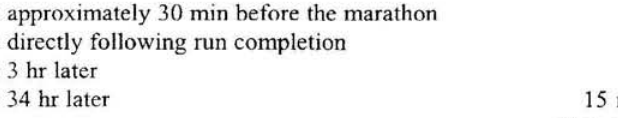
Table 2: Running time, weight loss, fluid intake as well as maximal oxygen uptake (VO2 max.) and oxy- gen utilisation (Ch-utilisation). Data shown as median values and 25" and 75'" percentiles in brackets, respec-